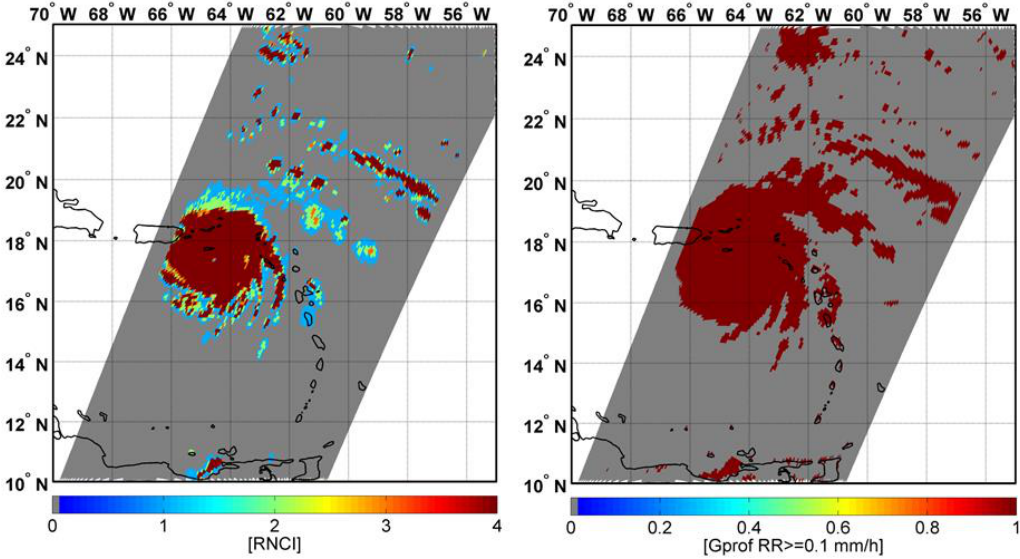
Figure 2. Hurricane Maria southeast of Puerto Rico, on 20 September 2017 at 02:03 UTC. Left panel shows the rainfall patterns obtained from Passive microwave Neural network Precipitation Retrieval (PNPR) v3 with the different RNCI values (0 to 4). The right panel shows the pattern obtained from the Goddard Profiling Algorithm (GPROF) V05 with a minimum rainfall rate threshold of 0.1 mm h −1 .